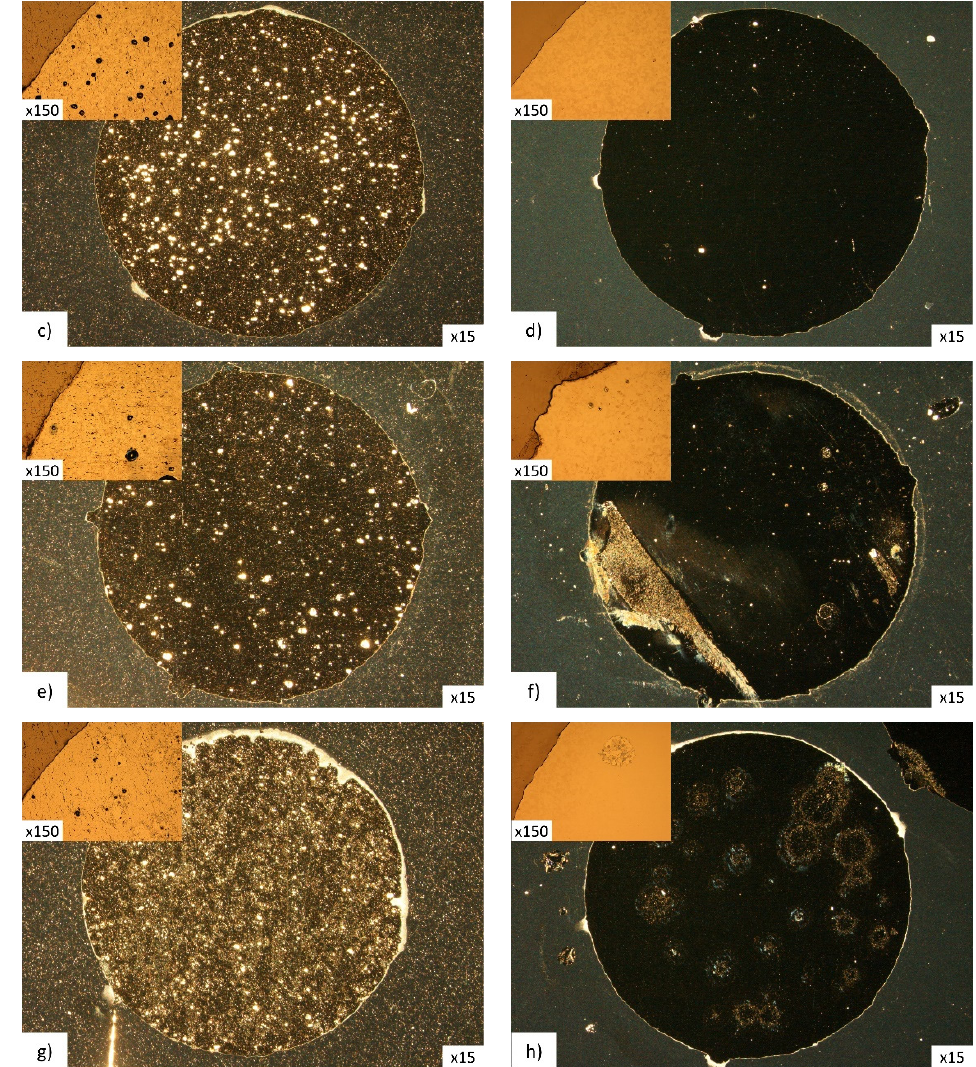
Figure 6. Coating surface after corrosion tests; coatings deposited on substrates in as delivery state (left column) and on polished ones (right column); ( a , b )—Cr interlayer; ( c , d )—S-phase (15 vol.% of N 2 ) interlayer; ( e , f )—S-phase (30 vol.% of N 2 ) interlayer; ( g , h )—S-phase (50 vol.% of N 2 ) interlayer (light microscopy).